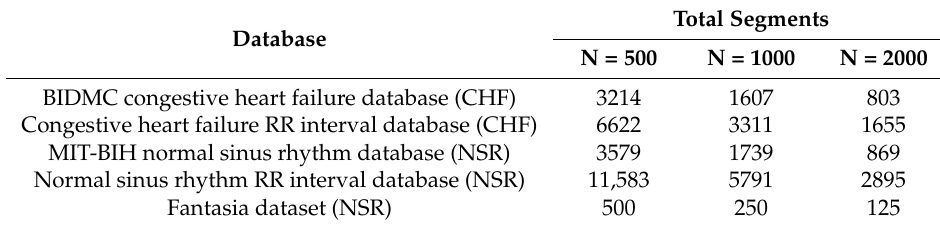
Figure 1. The original ECG signals and beat annotations. Table 1. The number of signals for different database in two classes.